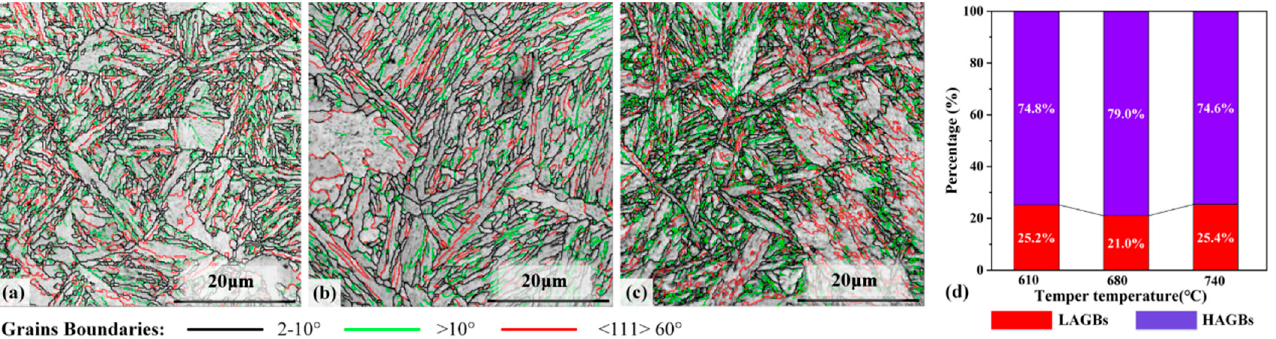
Figure 6. The low-angle grain boundaries (LAGBs) and high-angle grain boundaries (HAGBs) that are marked in the band contrast images of 35CrMo steel after tempering at di ff erent temperatures ( a ) 610 °C, ( b ) 680 °C, ( c ) 740 °C, and percentage stack histogram of LAGBs and HAGBs ( d ). ( a ) 610 ◦ C, ( b ) 680 ◦ C, ( c ) 740 ◦ C, and percentage stack histogram of LAGBs and HAGBs ( d